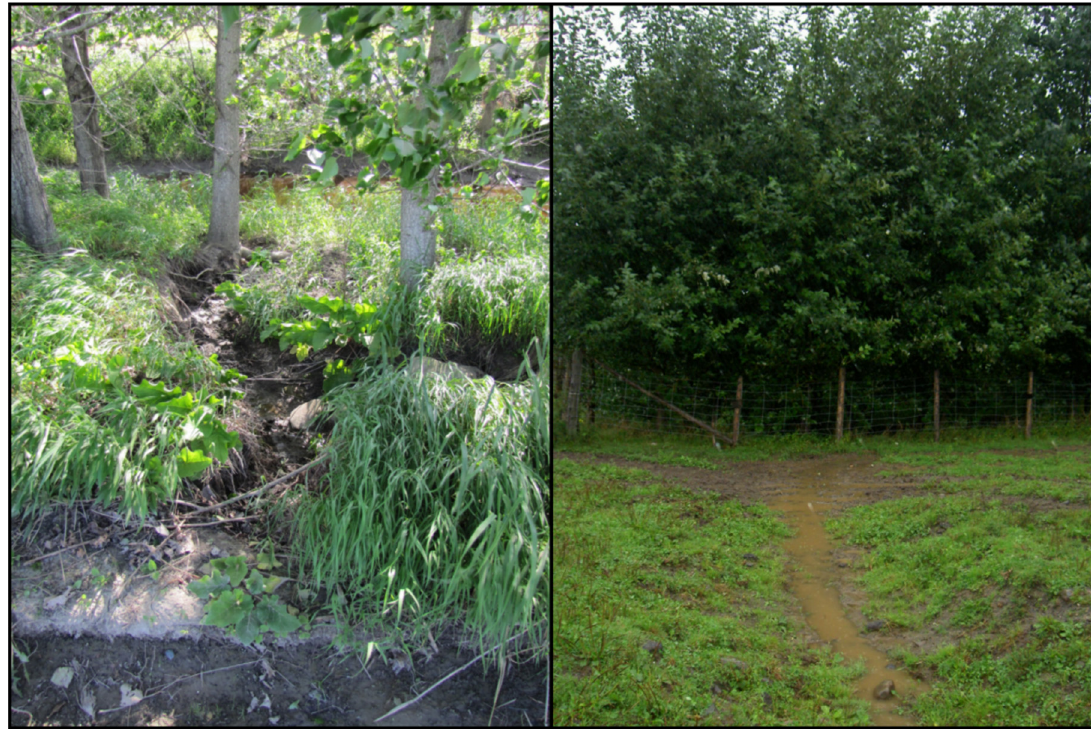
Figure 2. Examples of concentrated flow paths in hybrid poplar buffers established along a crop field ( left ) and along a pasture ( right ) riparian zone in southern Québec. In these hot spots for sediment and nutrient transport, wider buffers and additional conservation practices (ex: stiff-stemmed filter strip, ephemeral stream fencing) would be needed to allow surface runoff dispersion/infiltration and improve the water quality function [20].